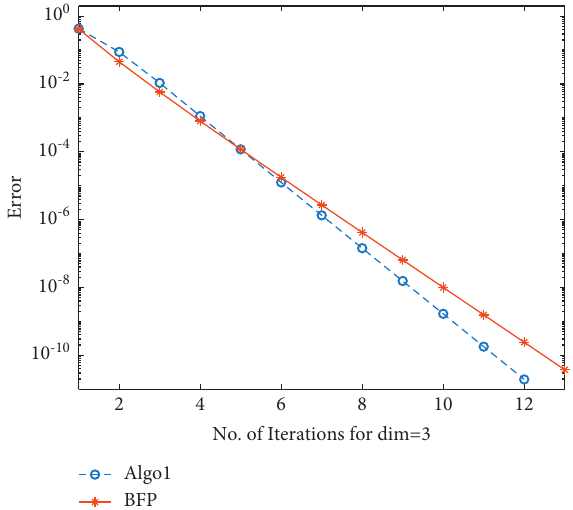
Figure 9: Iteration no. vs error for dimension